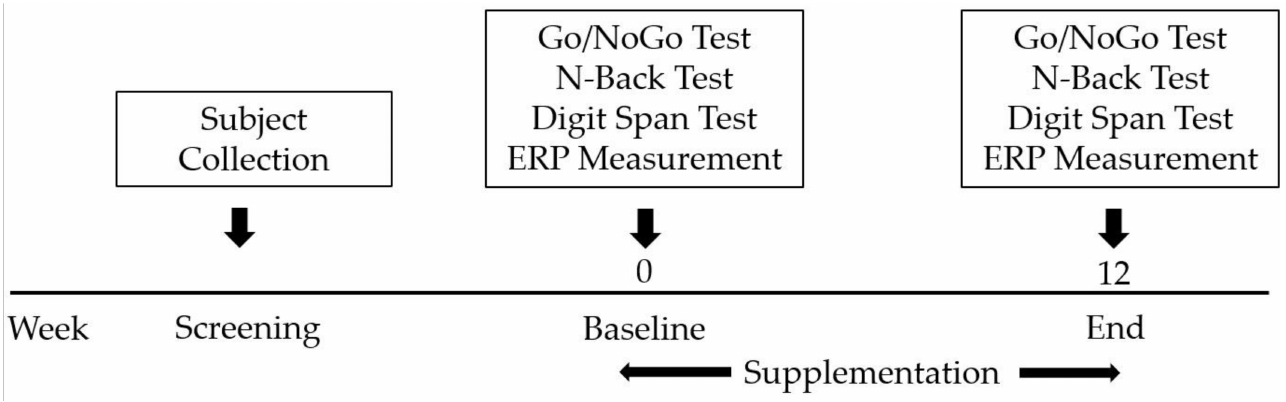
Figure 1. Schematic diagram showing intervention allocation groupings in the study.